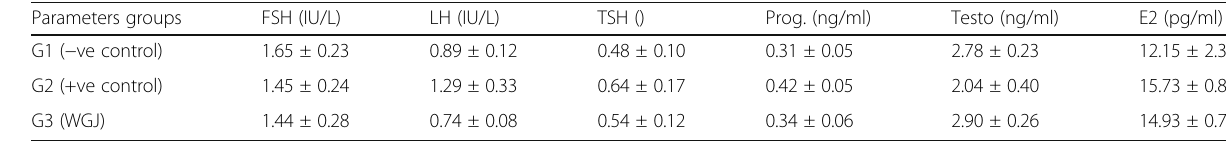
Table 9 The evaluation of sexual hormone in rats ’ blood serum Parameters